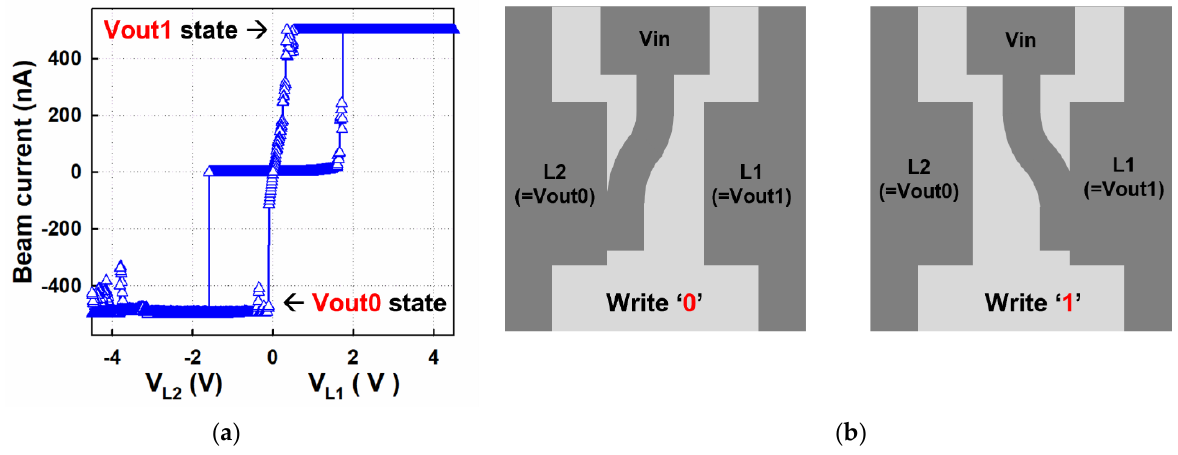
Figure 16. ( a ) Current-voltage curve of the NEM memory switch; and ( b ) conceptual illustration of beam movement by voltages.